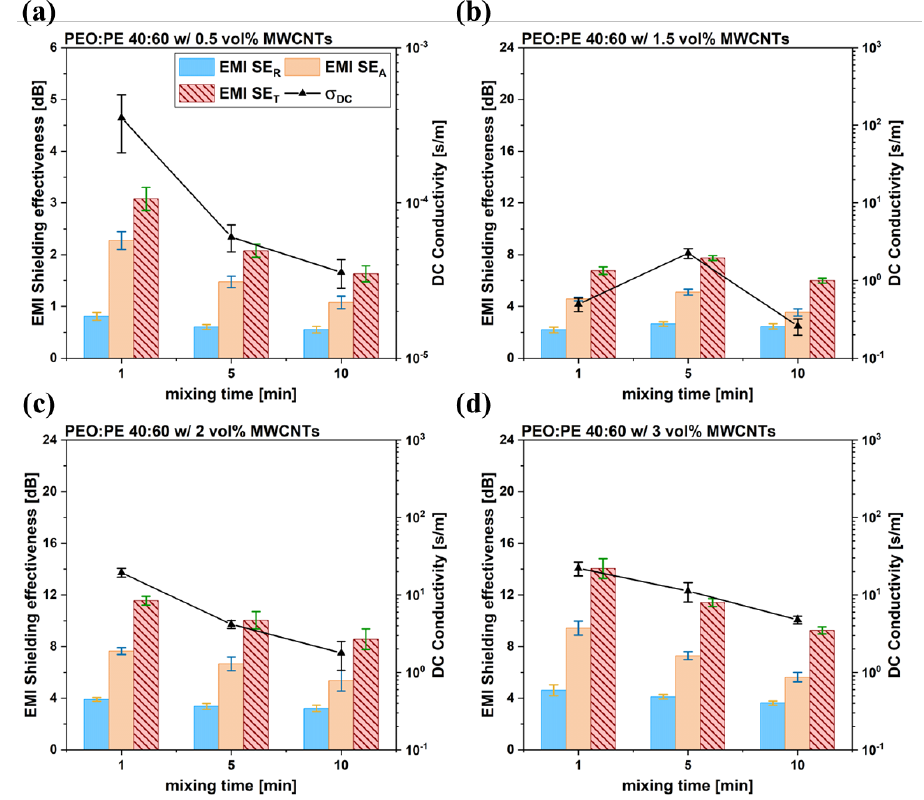
Figure 4. EMI SE values and DC electrical conductivity data for PEO/PE 40:60 blends containing MWCNTs at concentrations of ( a ) 0.5 vol%, ( b ) 1.5 vol%, ( c ) 2 vol%, and ( d ) 3 vol%.